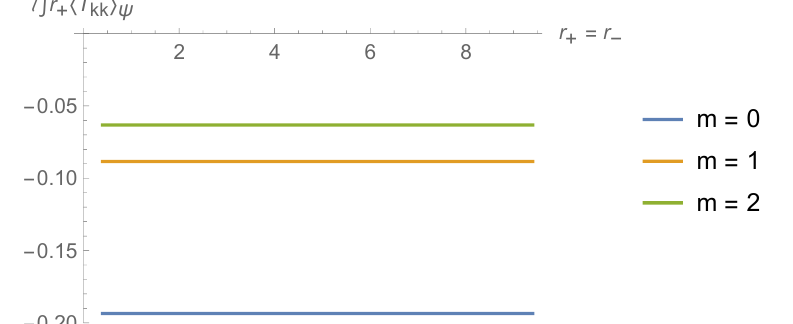
R (cid:25)= 2 Figure 5 . Plot of the quantity ‘ R 1 d(cid:30)dUr + h T kk i at extremality for m = (0 ; 1 ; 2) and 0 (cid:0) (cid:25)= 2 ‘=R S = 10. The cuto(cid:11) (cid:15) = 0 : 01, the sum over Kaluza-Klein modes modes was performed to 1 N = 200, and the sum over BTZ images was performed to n = 3. This quantity appears constant for all values of r + , up to corrections at small r + for the small value of N . Relevant values of the four-dimensional mass m are indicated above.